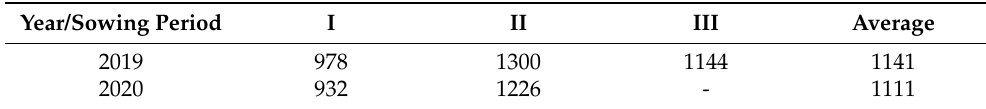
Table 2. Growing degree days per growing cycle I (spring sowing period), II (late spring), and III (summer).